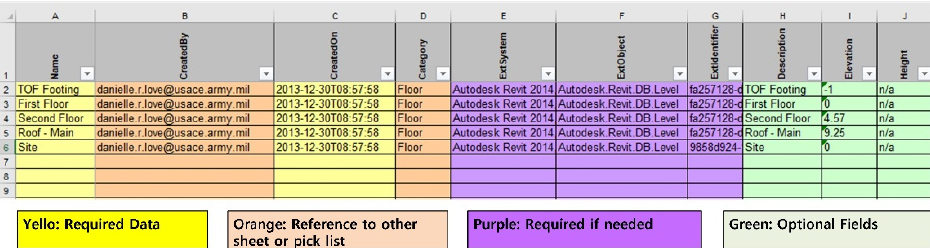
Figure 3. Example of COBie floor sheet (Adapted from SampleCOBieSpreadsheet provided by Au- todesk).